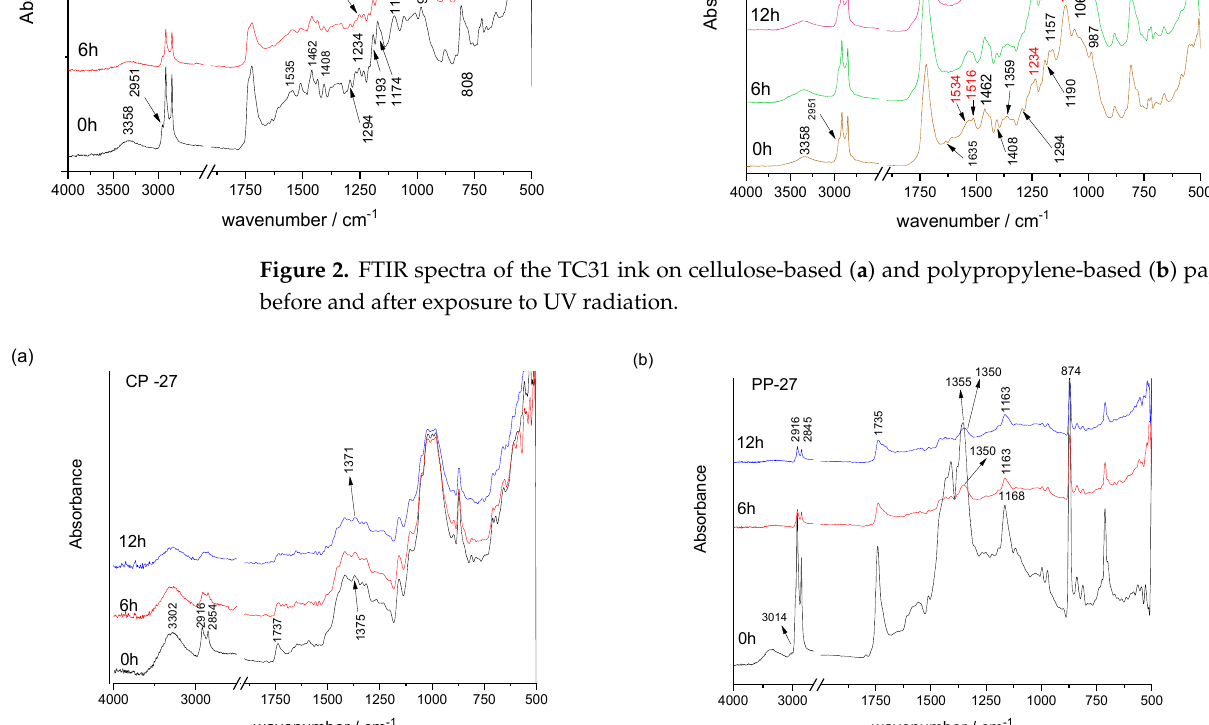
Figure 2. FTIR spectra of the TC31 ink on cellulose-based ( a ) and polypropylene-based ( b ) paper before and after exposure to UV radiation. Figure 3. FTIR spectra of the TC27 ink on cellulose-based ( a ) and polypropylene-based ( b ) paper before and after exposure to UV radiation.